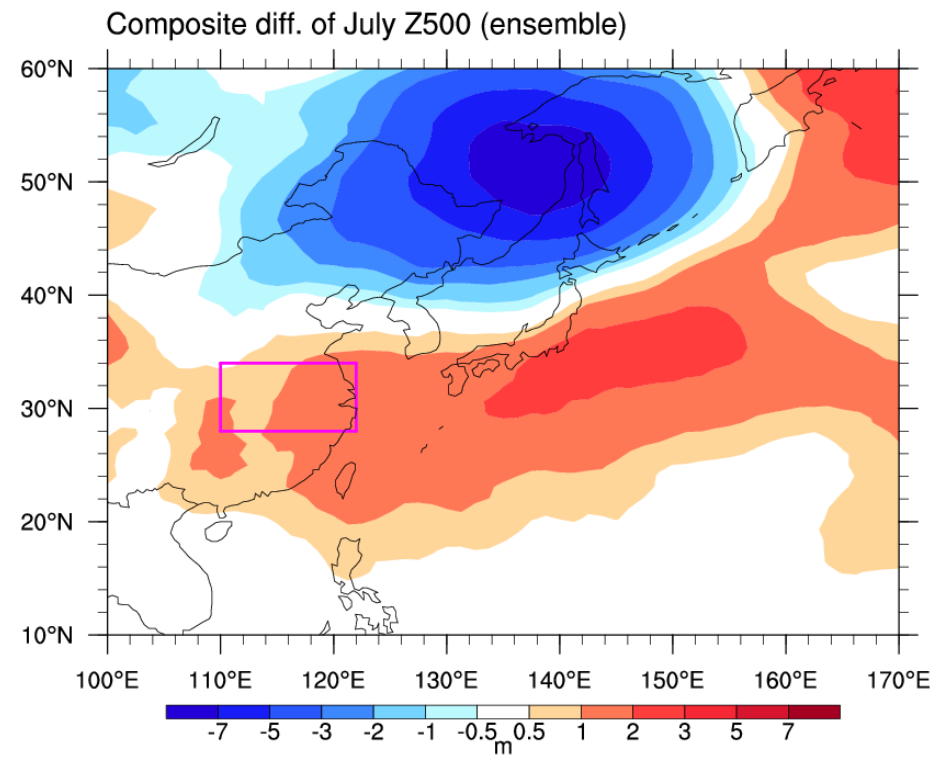
Figure 12. Composite difference of Z500 (shading; unit: m) in July between five lowest and highest MA–mean ASIAI years during 1920–2005. The results are based on the ensemble mean of 35 members of CESM–LENS historical simulations. The magenta box denotes the research domain of the YHRB Meiyu region.